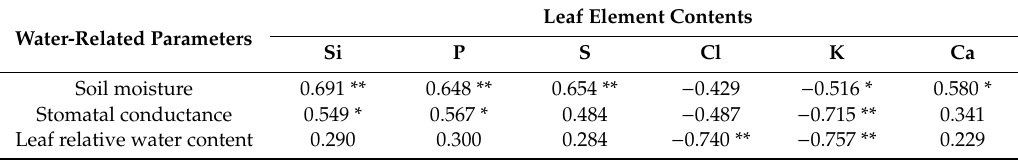
Table 5. Pearson correlations between proso millet leaf element contents and water-related parameters. Water-Related